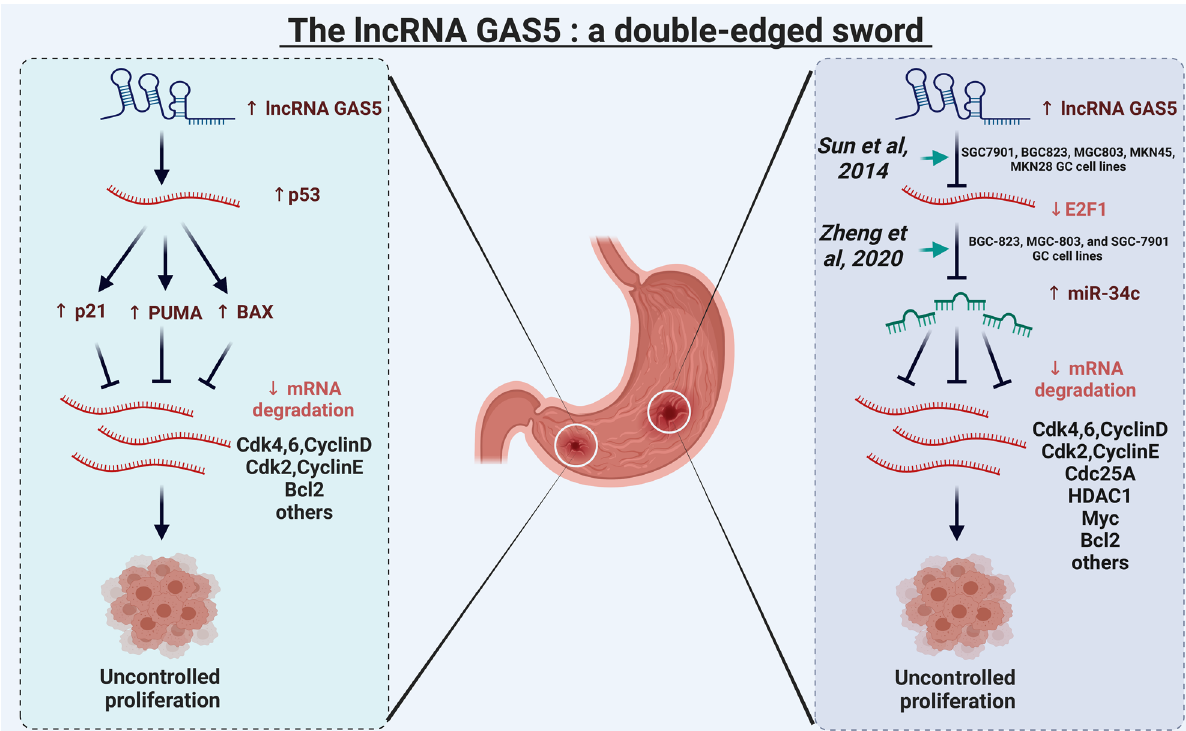
Figure 4. lncRNA-GAS5: a double-edged sword in tumor growth and proliferation in GC. On the left (highlighted in the green box), p53 was directly activated by lncRNA-GAS5 in GC 45 . Once p53 expression is activated, it may induce p21 68 , PUMA/BAX 68 . Although, the expression of p21 does not depend on the p53 functionality in GC 7,8 . Despite this fact, activated p21 and PUMA/BAX, which directly inhibit the expression of the CDK4/6-CyclinD and CDK2-CyclinE, Cdc25A, Bcl2, and others and induce cell cycle arrest and apoptosis at the G1/S checkpoint. On the right (highlighted in the purple box), the novel tumor suppressor mechanism of lncRNA-GAS5 is captured by the Boolean network. Overexpression of lncRNA-GAS5 directly inhibits E2F1 expression 15 , which triggers miR-34c expression 3 . Then, overexpression of miR-34c directly targets the CDK4/6- CyclinD and CDK2-CyclinE, Cdc25A, HDAC1, Myc, Sirt1, Mdm2, and Bcl2, see the review by Xiong et al. 67